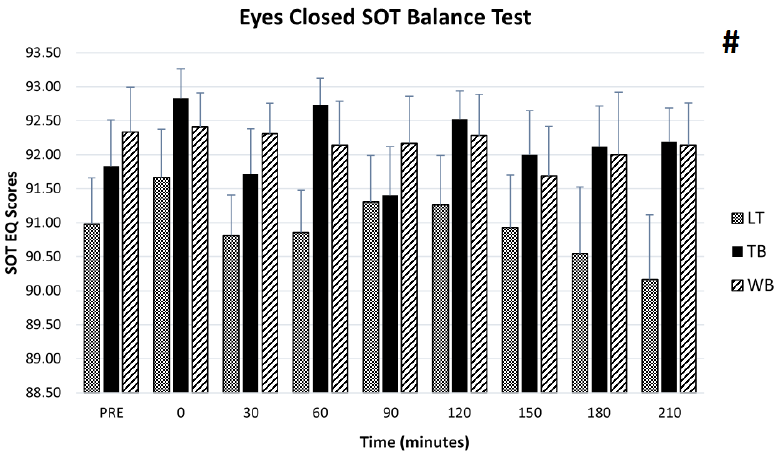
Figure 3. Mean SOT EQ scores from the eyes closed (EC) condition for all three footwear (LT, TB and WB) at nine time points. # represents a significant main effect for footwear. Bars represent standard errors.